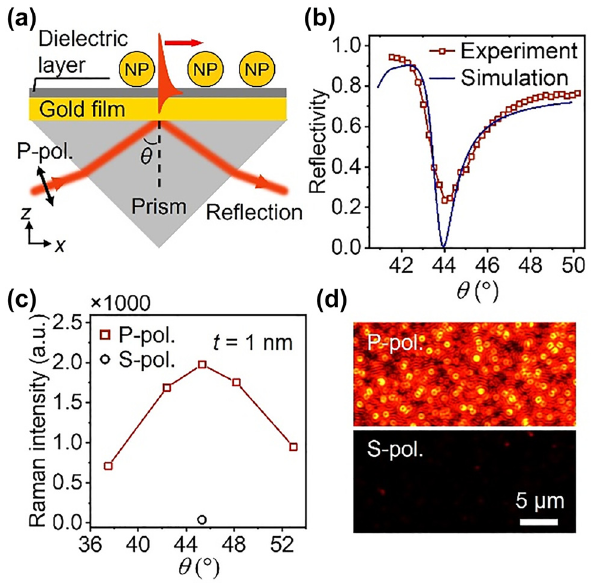
Figure 1: Exciting NPOM system by prism coupling. (a) Schematic of the NPOM excited by SPPs in the Kretschmann configuration. The thickness of the gold film is 45 nm, and the diameter of AuNP is 60 nm. The laser wavelength is 632.8 nm, and the thickness of dielectric layer is defined as t . (b) Measured and simulated reflection curves of a clean gold film under p-polarized light incident. (c) Plot of SERS intensity of 4-MBA molecules at 1075 cm − 1 as a function of the incident angle. The thickness of Al 1 nm. (d) Dark-field images of the NPOM substrate excited by p- (s-) polarized light at the angle of 45.32 ◦